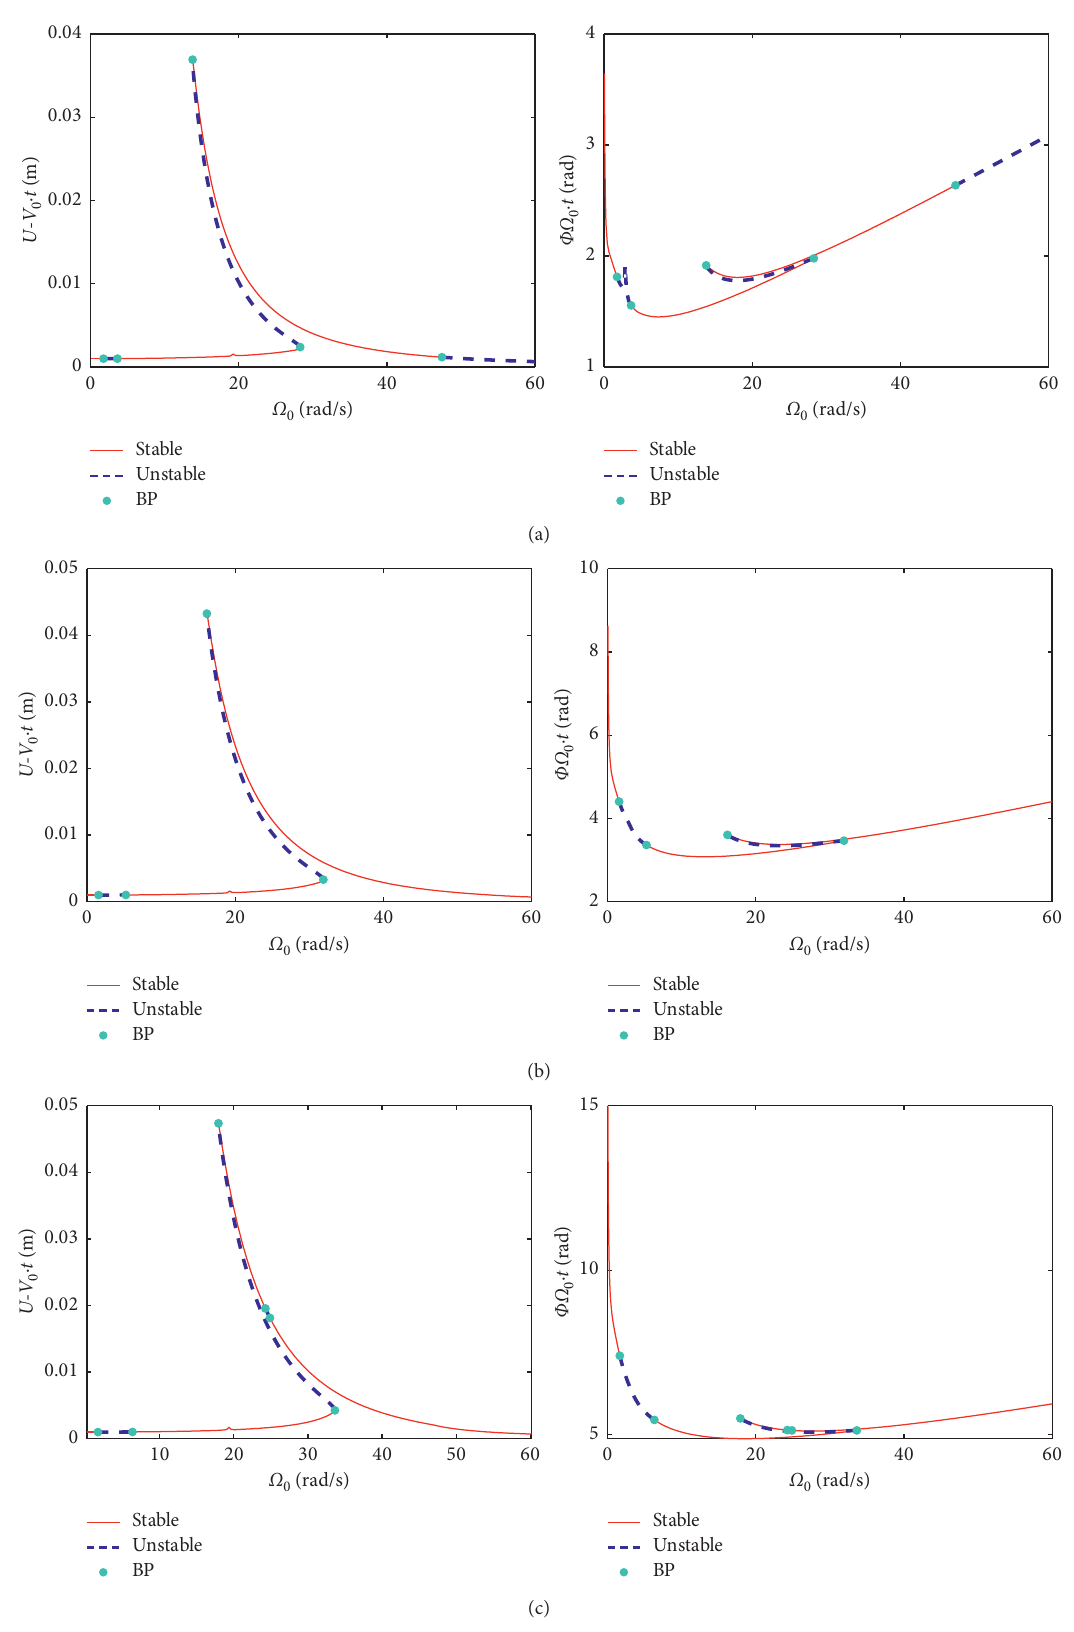
Figure 4: Amplitude-frequency curve of the system as k